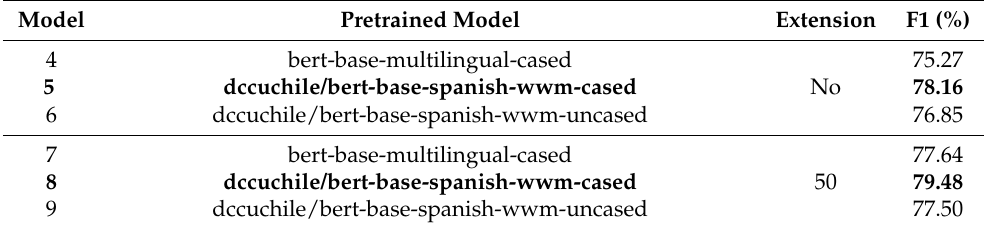
Table 3. Summary of results for bidirectional encoder representations from transformers (BERT) model (named entity recognition (NER)-based inputs in all cases).